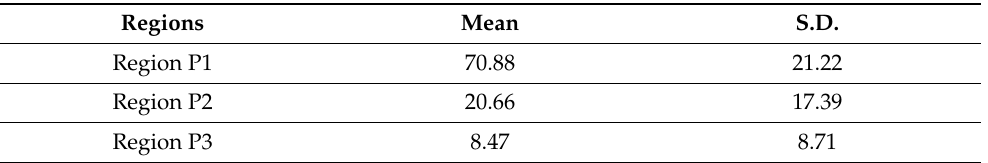
Table 2. Mean value and standard deviation of ratios in each study referring to the spots where most of injuries of recurrent laryngeal nerve happened during